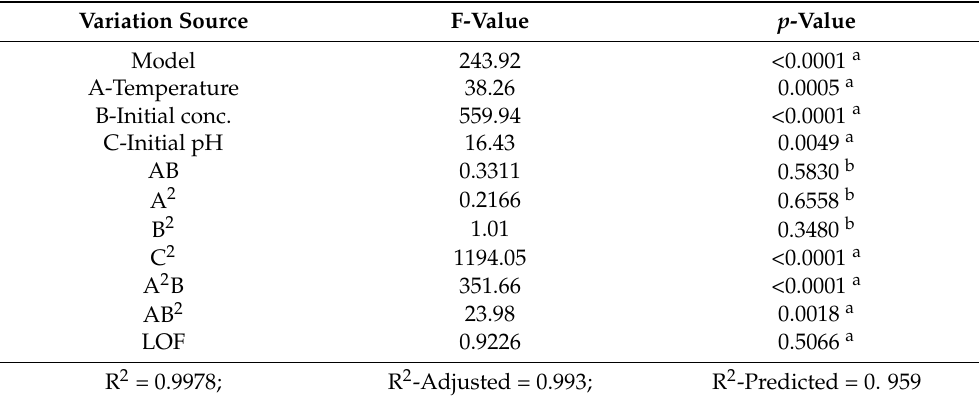
Table 2. ANOVA for a reduced cubic model for SBAC-MgAlFe-LDH phenol adsorption capacity